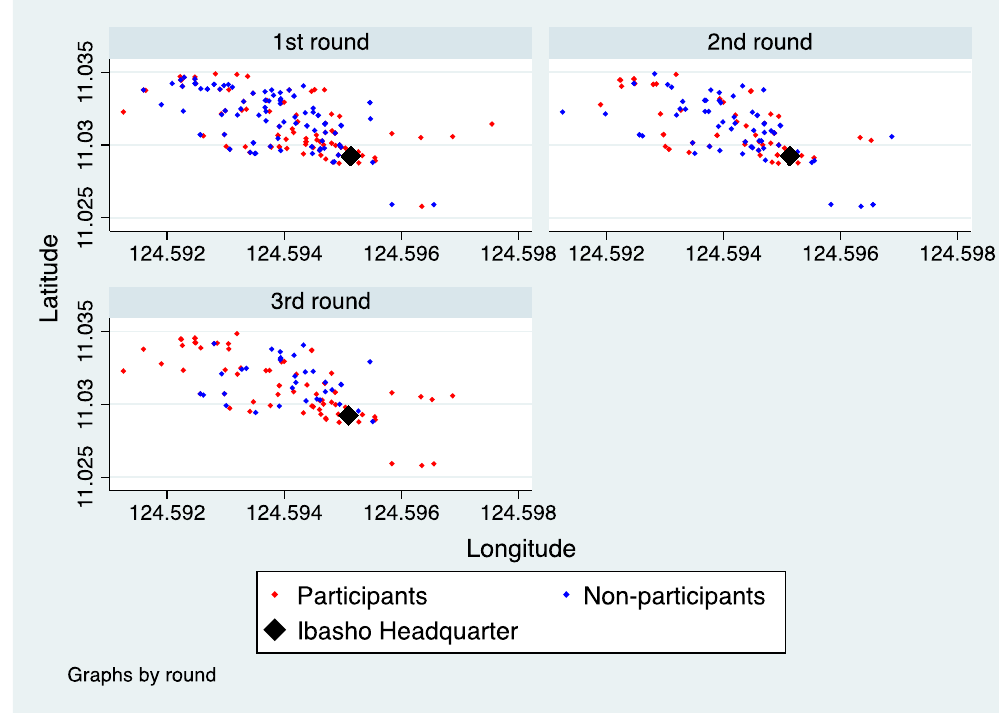
Figure 1. Household location and participation status in each round (Philippines). Note : The graph shows the location (latitude and longitude) of the sample households for participants (red) and non-participants (blue). It also shows the location of Ibasho headquarter (in black